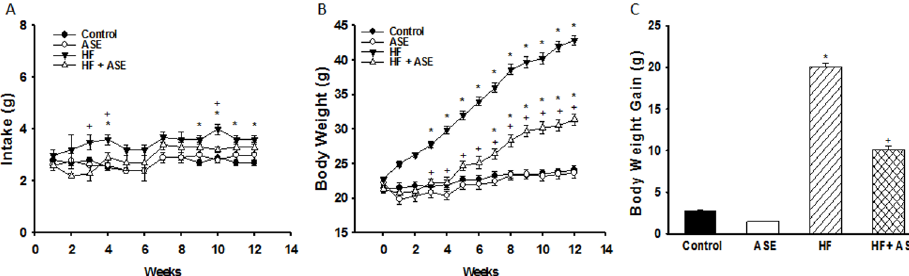
Fig 3. Food intake and body weight. Effects of ASE on food intake (A) and body weight (B) were analyzed weekly. Body weight gain (C) was measured from the 4 th week until the 17 th week in HF fed mice. Values are means ± SEM, n = 8 for all groups. * Significantly different from the control and ASE groups (p (cid:1) .05). + Significantly different from the corresponding HF group (p (cid:1) .05). # Significantly different from the control and ASE groups (p (cid:1) .05).